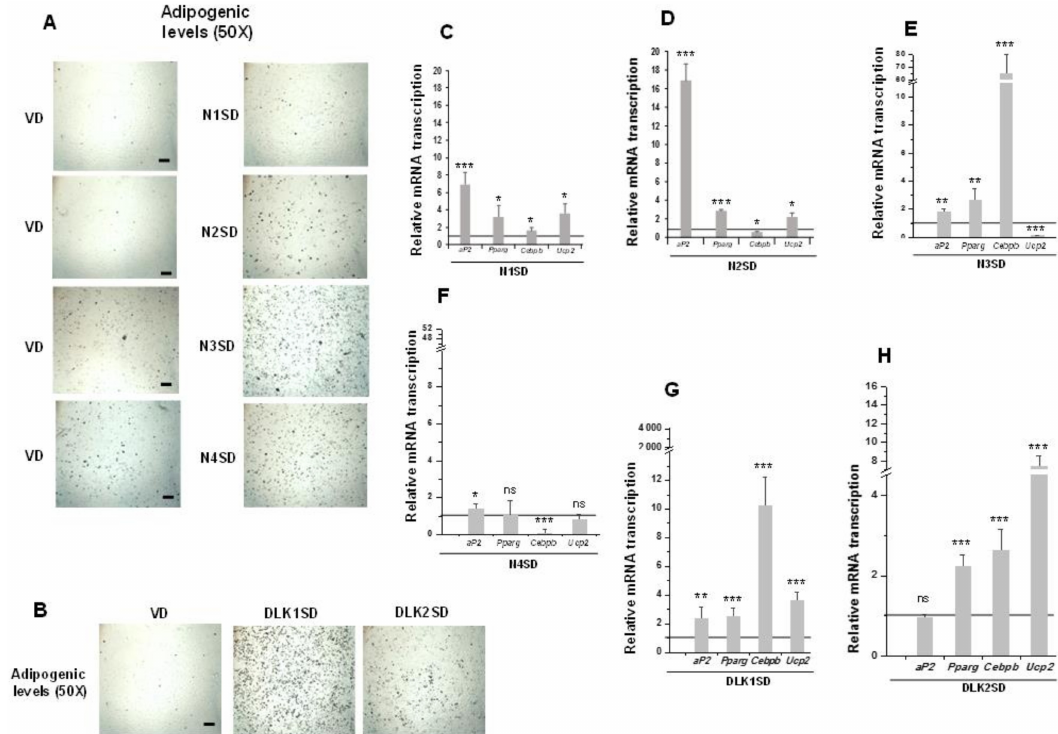
Figure 4. Stable overexpression of Notch and Dlk genes in multipotent C3H10T1 / 2 cells